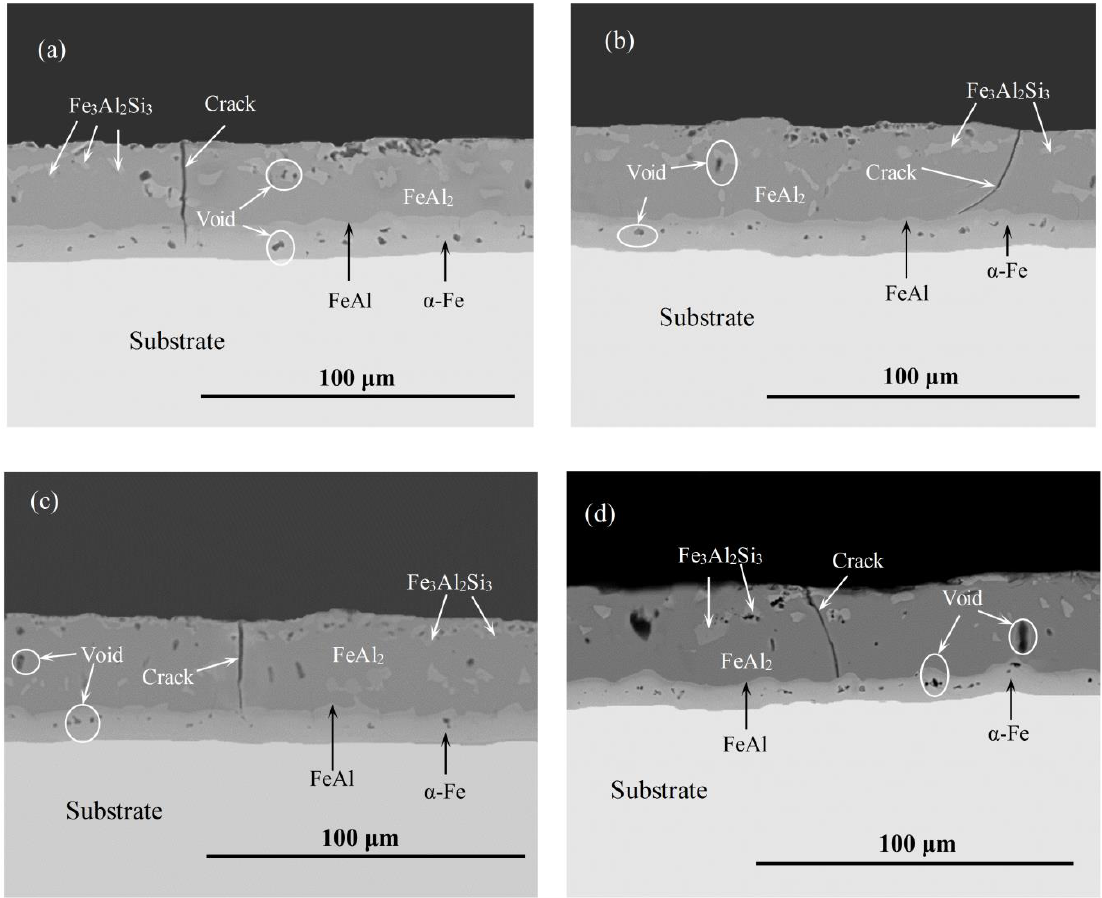
Figure 9. Influence of three-step heating methods on properties of Al–Si coating boron steel sheet of ( a ) Scheme A, ( b ) Scheme B, ( c ) Scheme C, and ( d ) Scheme D. The bright α -Fe phase located near the substrate was a solid solution of Al and Si atoms in the high temperature. The α -Fe phase has the feature of the preferable plasticity